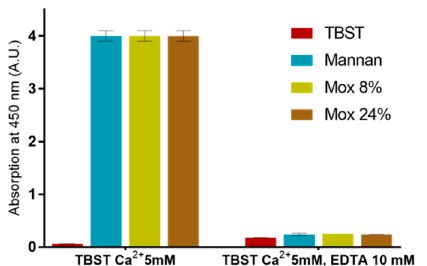
Figure 9. Calcium involvement in mannan recognition using EDTA-based assessments with different mannan at 250 ng/mL and MBL.